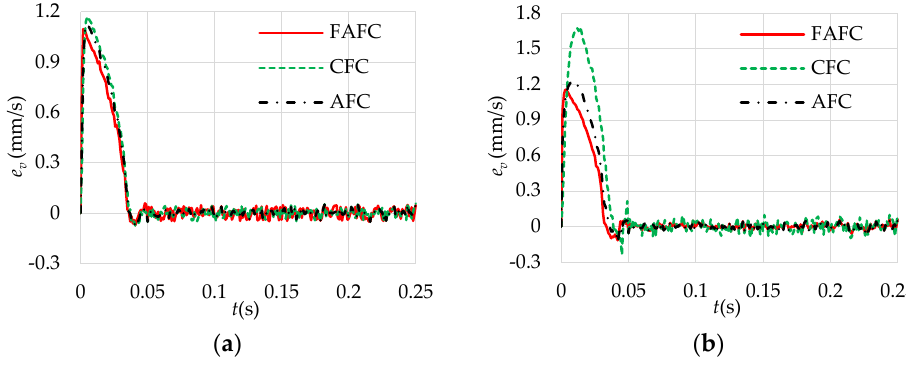
Table 5. Performance of CFC, AFC, and FAFC under Case (200, 105, 194, 25). Figure 8. e v ( t ) of CFC, AFC, and FAFC, ( a ) Case (200, 105, 194, 25), ( b ) Case (200, 175, 191, 50).